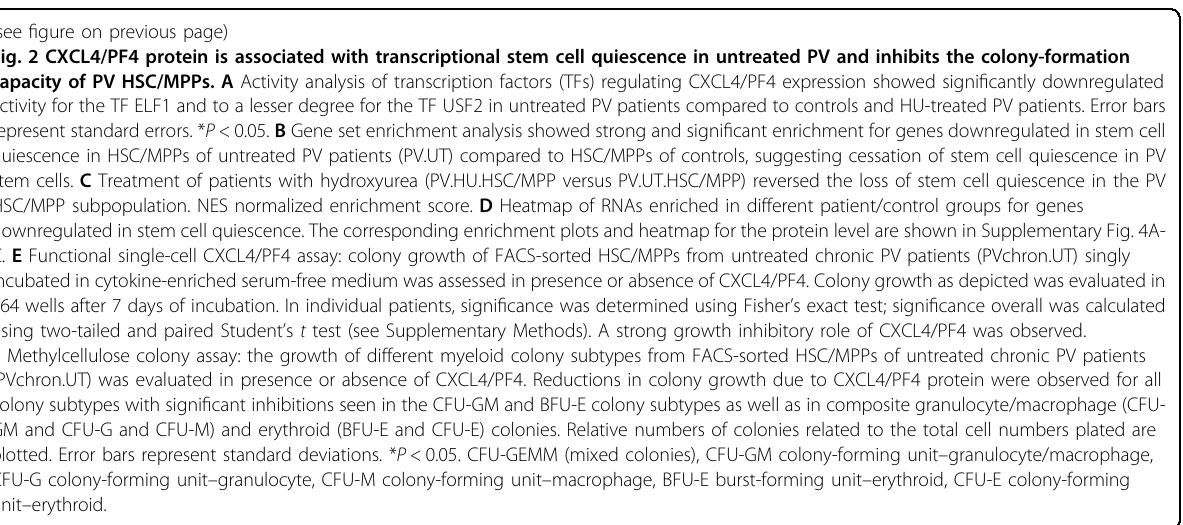
for FACS-sorted HSC/MPPs from PV patients (Fig. 2F).